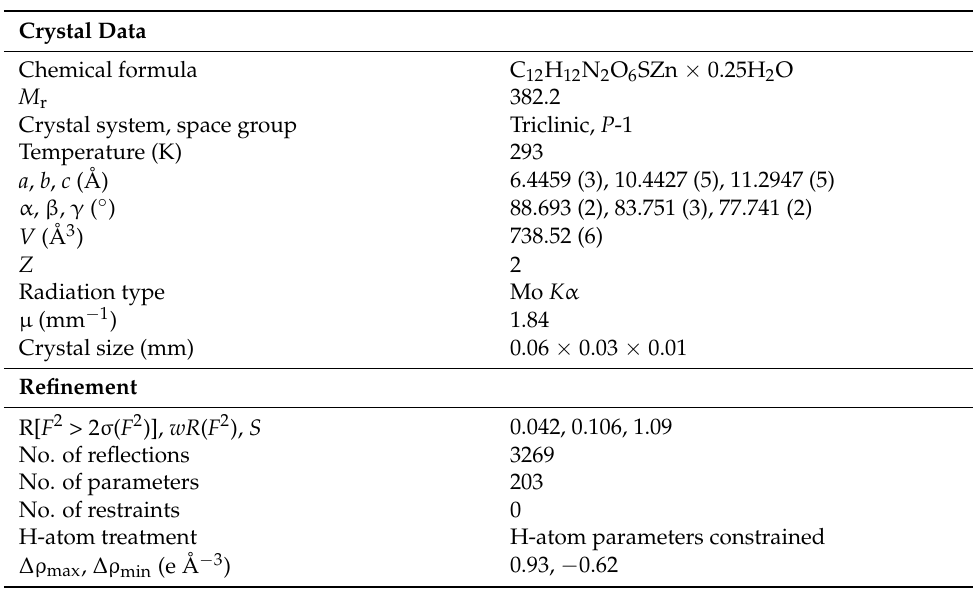
Figure 1. ( a ) XRPD patterns and ( b ) FTIR spectra of TPDCA ligand, QUF-001, QUF-002 and QUF-003. ( c ) TGA curves of QUF-001, QUF-002 and QUF-003. ( d ) TGA and DTA curves of QUF-001. Table 1. Crystal data and structure refinement of